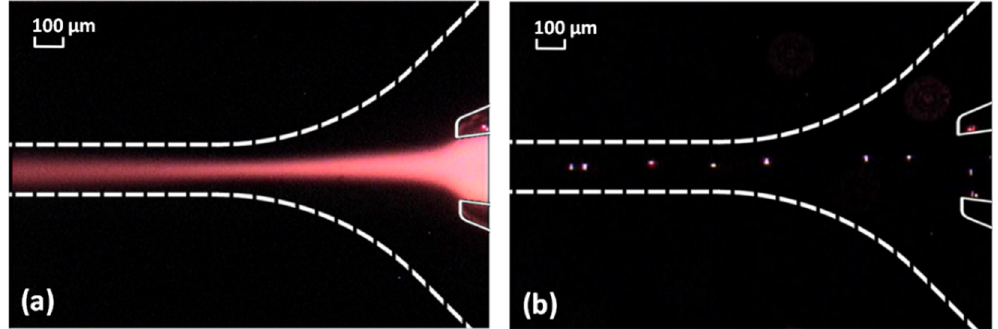
Figure 3. ( a ) Fluorescent dye squeezed into a narrow stream by neighboring sheath flows, ( b ) focused red fluorescent-labeled particles with a size of 15 µ m focused into a single stream for detection and analysis purposes.